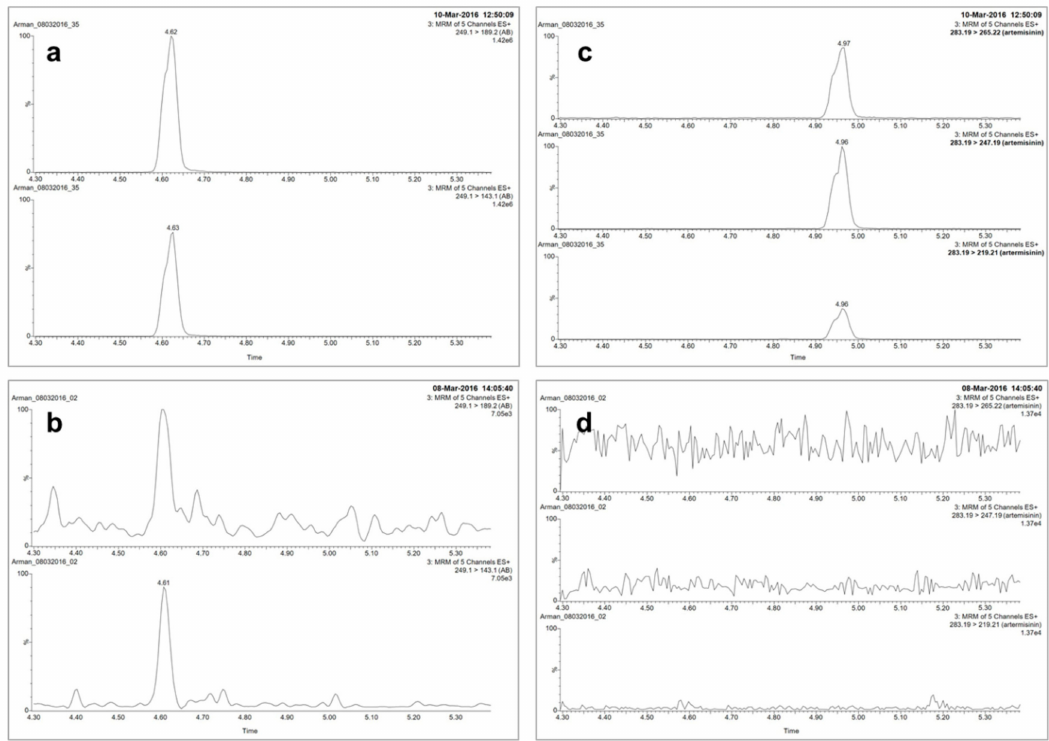
Figure 1. UPLC-MRM-MS analysis of arteannuin B. ( a ) UPLC-MRM-MS of arteannuin B standard fragmented in MRM channels of m / z 249.1 > 189.2; 249.1 > 143.1 ( b ) UPLC-MRM-MS analysis